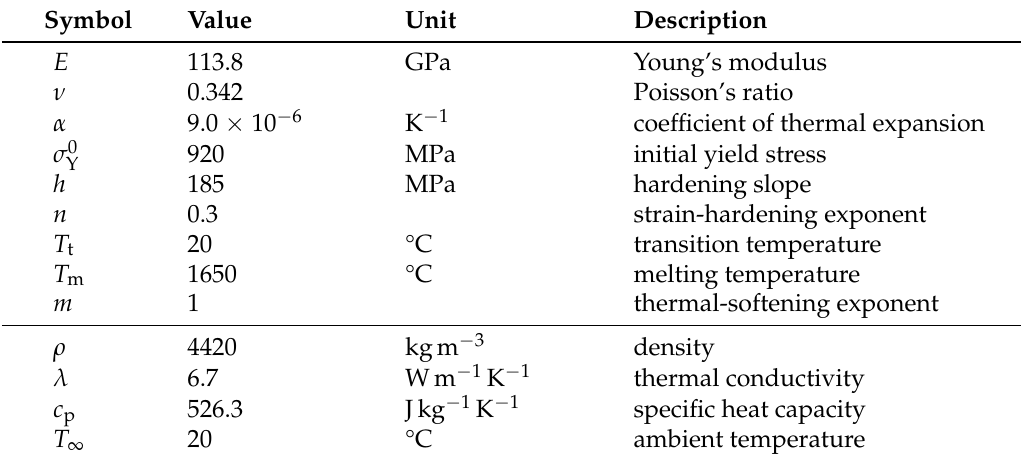
Table 1. Baseline constitutive parameters for our numerical investigations if not specified